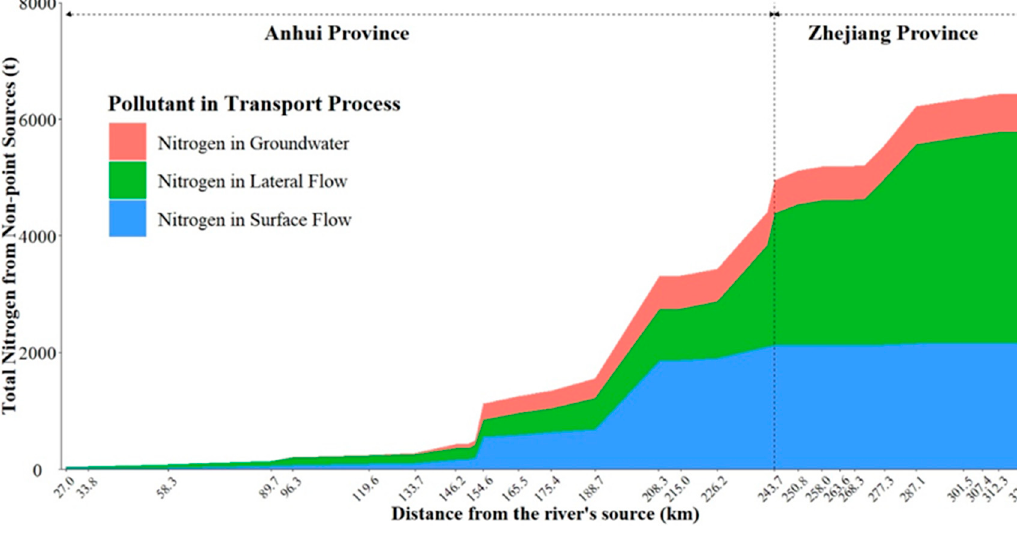
Figure 8. Average annual contributions of non-point sources of TN pollution along the main reach of the Xin’anjiang River.